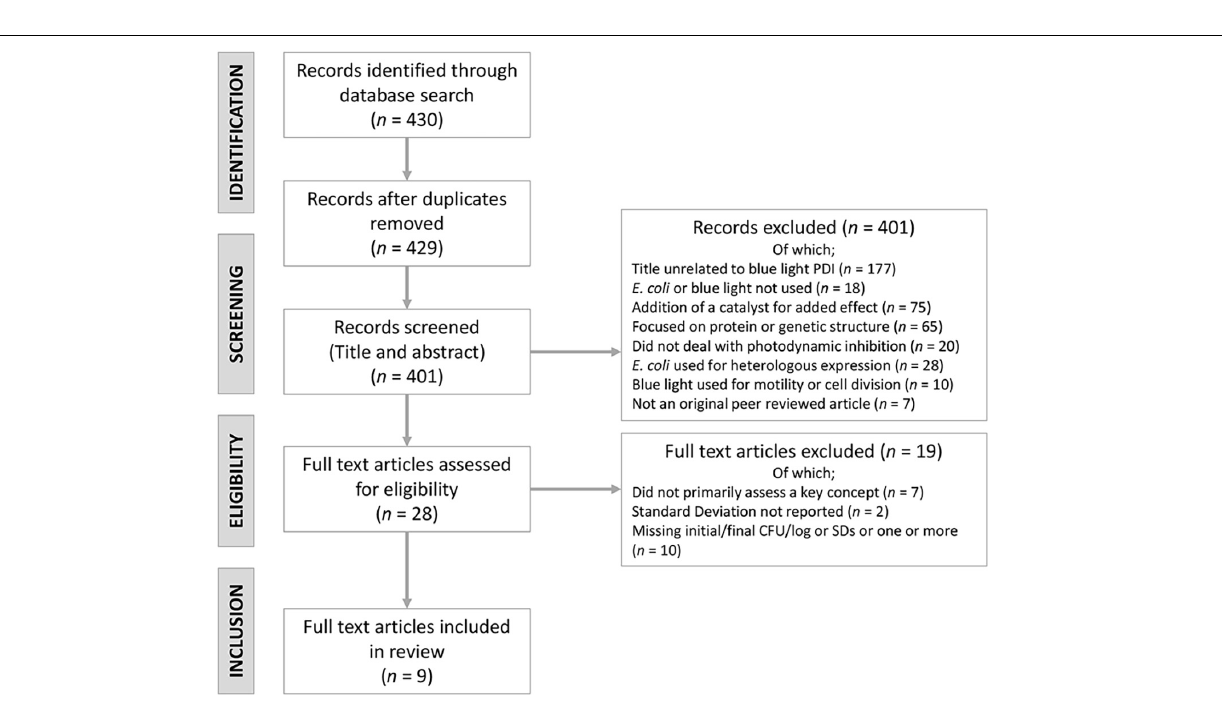
FIGURE 2 | Search criteria and process for selecting articles included in the